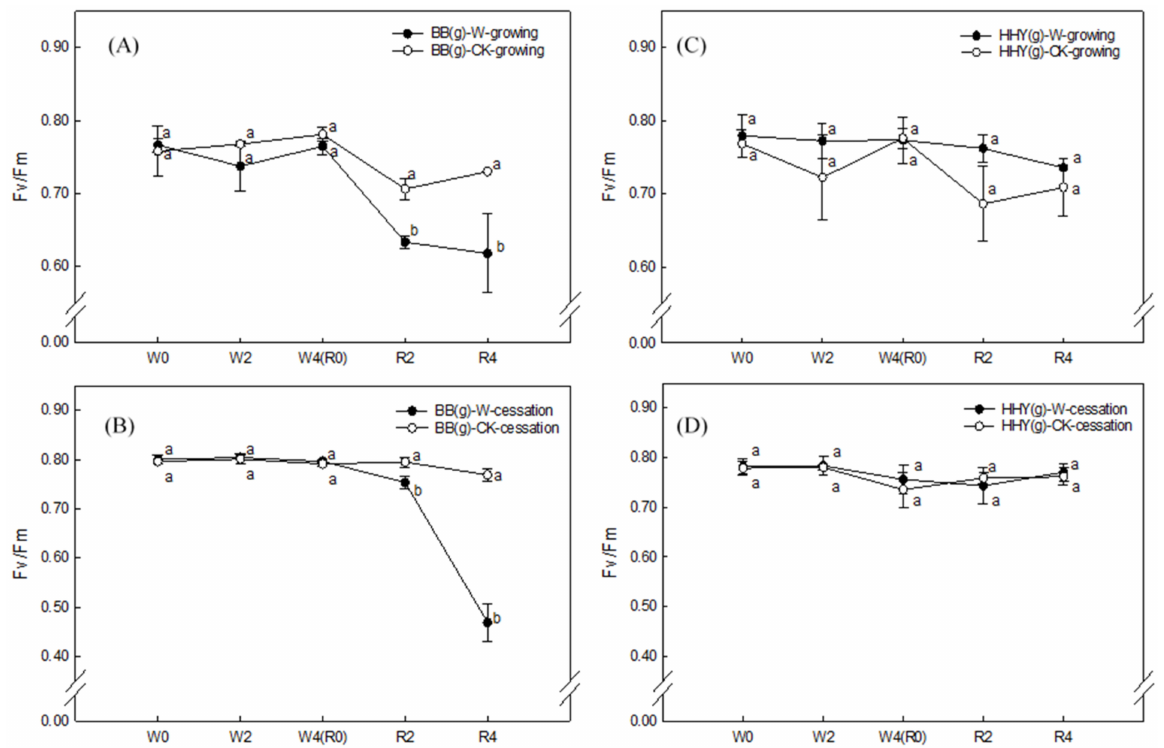
Figure 3. The Fv/Fm of grafted seedlings of ‘Black-Beauty’ (BB) ( A , B ) and ‘Hung-Hsin-Yuan’ (HHY) ( C , D ) treated with waterlogging (W0, W2, and W4) during the growth period or the growth cessation and continuously investigating the post-waterlogging recovery period (R0, R2, and R4). Bars indicate the standard deviation of three replicates, and the different letters represent the significant difference between the treatments on the same investigated